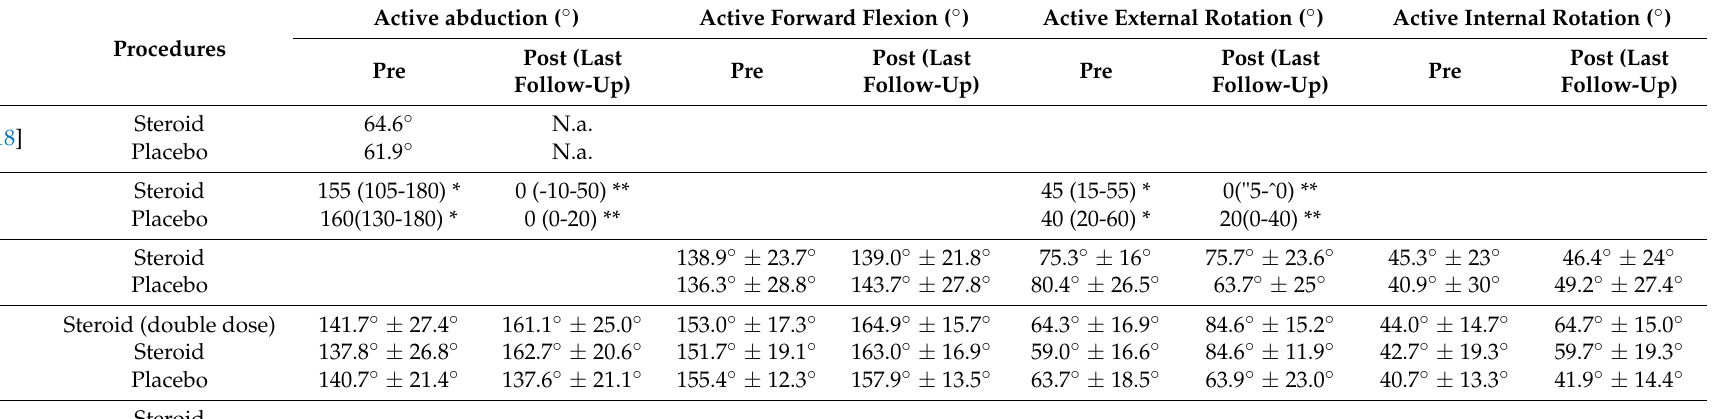
Active Internal Rotation ( ◦ ) Post (Last Post (Last Post (Last Post (Last Pre Pre Pre Pre Follow-Up) Follow-Up) Follow-Up) Follow-Up)